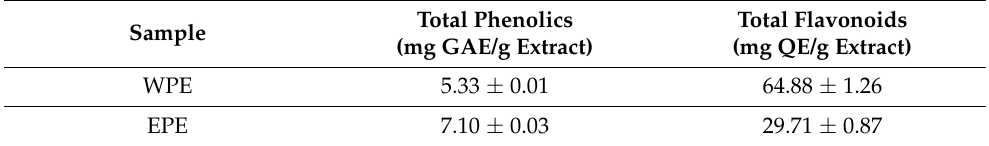
Table 4. Total phenolics and flavonoids in aqueous and ethanolic extracts of S. diversifolia leaves.